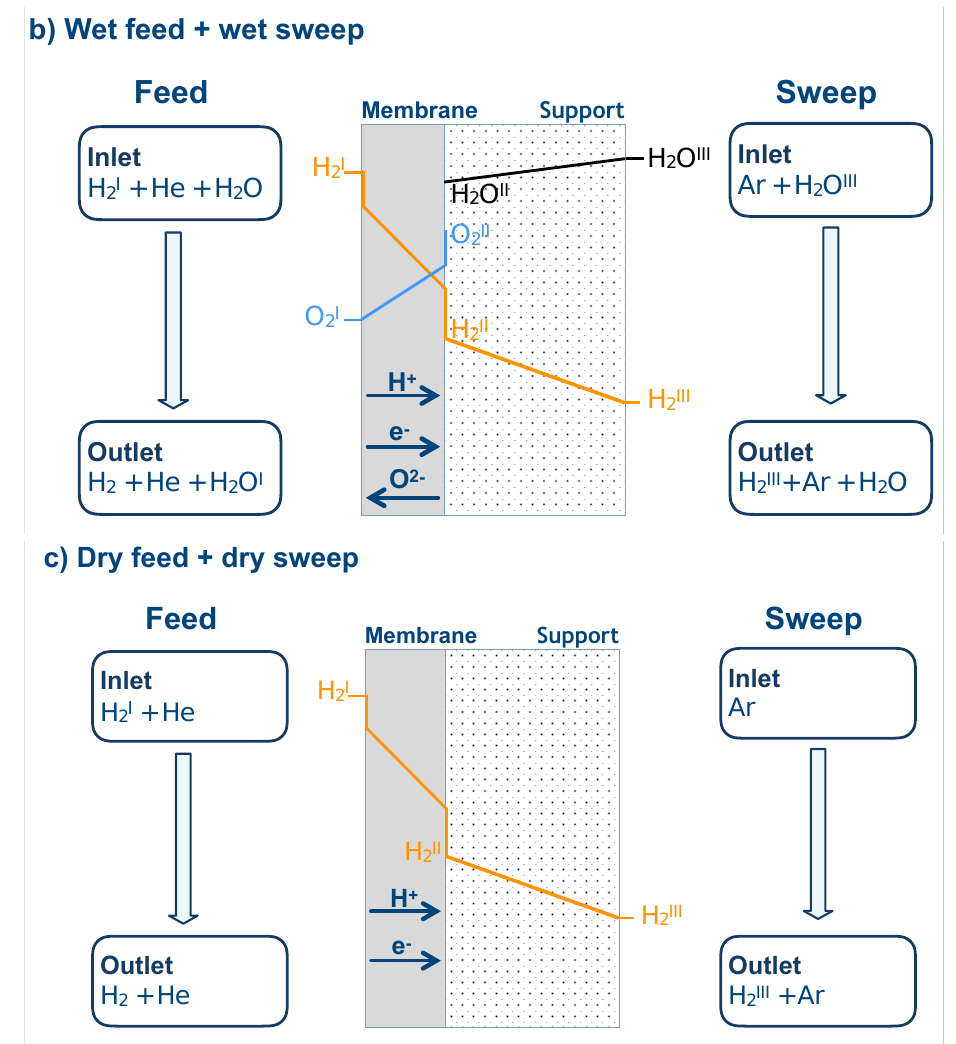
Figure 9. Schematic illustrations of gas transport along asymmetric membranes under various feeds and sweeps. Partial pressure changes along the membrane surface, bulk, and porous support are also visually plotted.